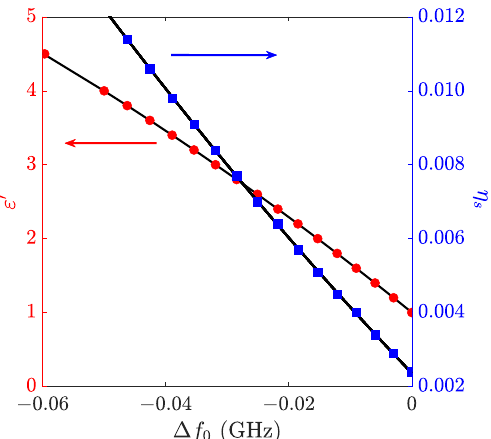
Figure 10. Calibration curves ε (cid:48) ( ∆ f 0 ) (red circles) and η s ( ∆ f 0 ) (blue squares). The points are obtained with e.m. simulations and fitted with a 2nd-order polynomial. The obtained calibration curves are reported in Equations (10) and